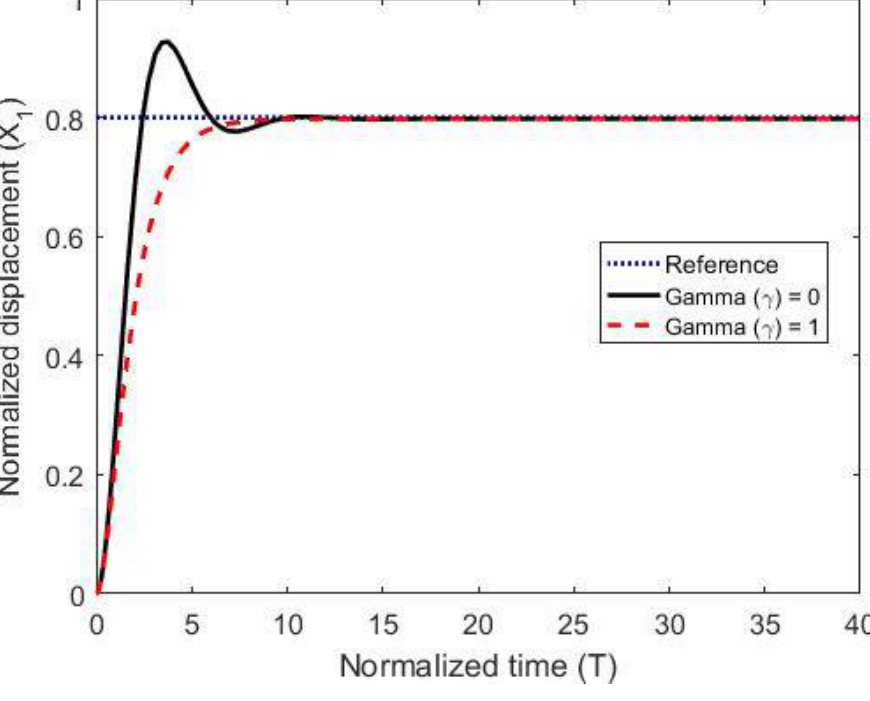
Figure 5. The normalized displacement with and without the coupling constant at a gap distance of 0.8.